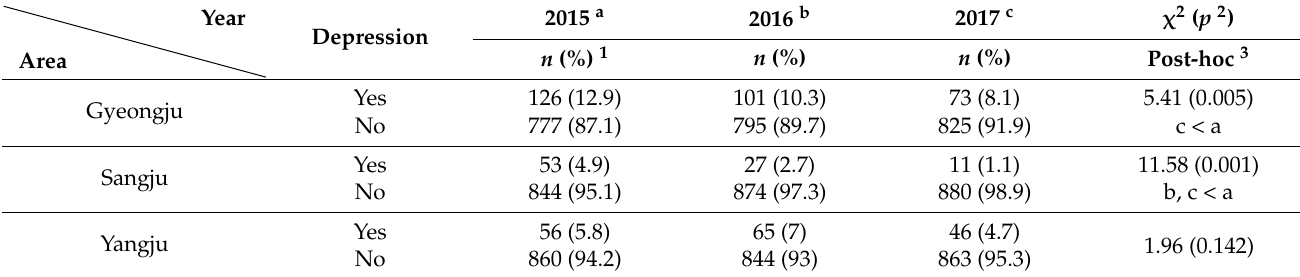
Table 3. The differences in depressive experience rate in three regions from 2015 to 2017 ( n = 8102).